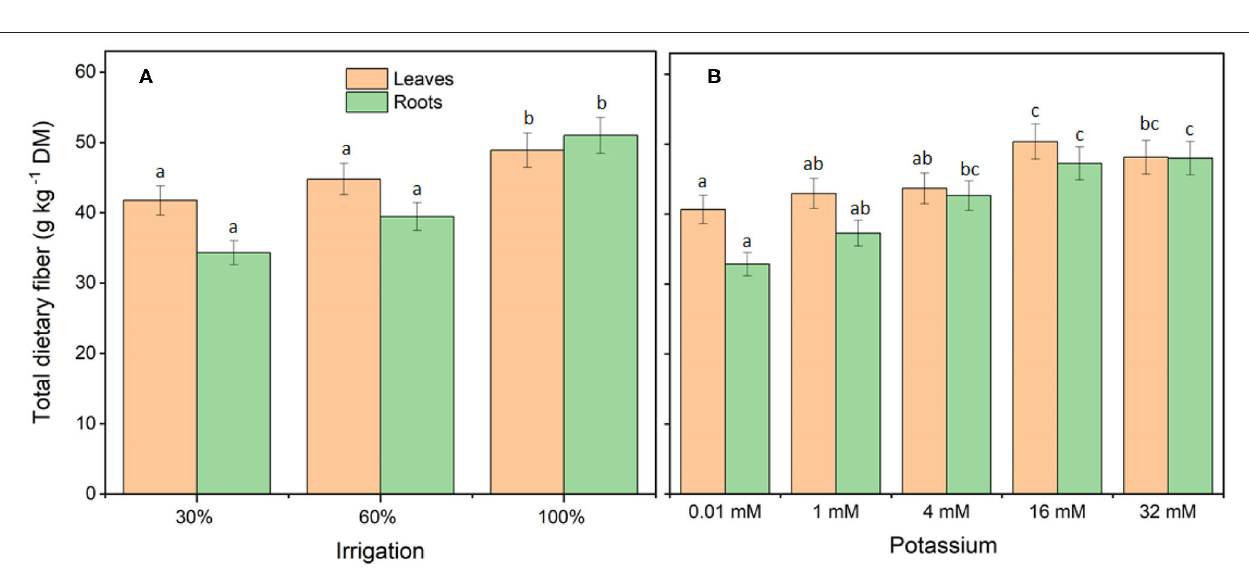
FIGURE 2 | Total dietary fiber content of young cassava plants in response to deficit irrigation (A) and potassium fertigation (B) . Total dietary fiber content in leaves and roots were both affected by irrigation ( P < 0.001) and K ( P < 0.001) but no treatment interactions (I × K) were observed in leaves ( P = 0.816) and roots ( P = 0.382). Treatments were initiated 30 days after planting and lasted 60 days. The data from four separate experiments were combined and shown as means ± standard errors; n = 4–16 replicate plants. Means followed by different letters in the same graph are significantly different (Tukey’s test P < 0.05).